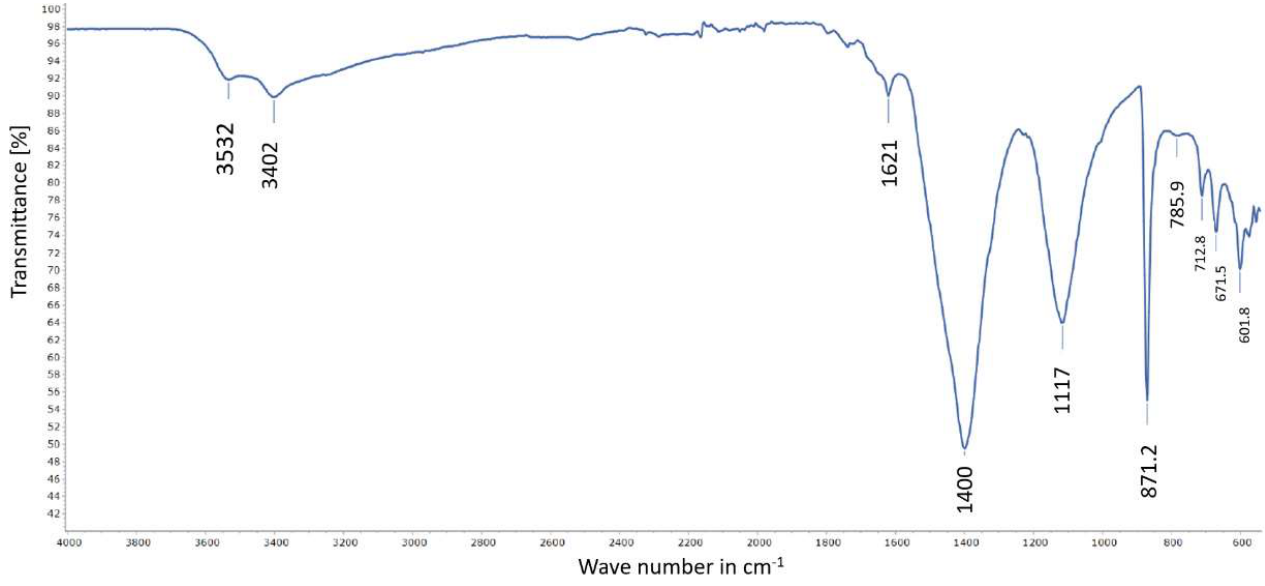
Figure 18. FTIR spectrum of a sample from Stefføya showing the co-existence of calcite and gypsum.